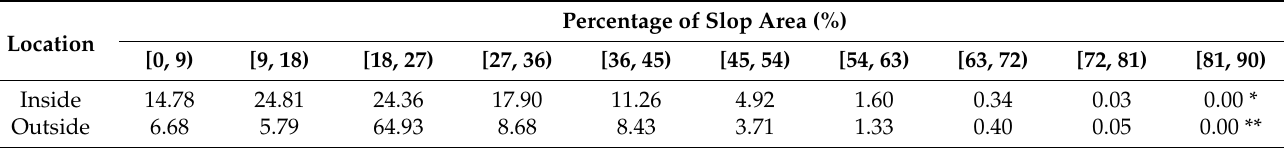
Table 6. Statistical results of the proportion of the inside and outside slope area of the pit rim